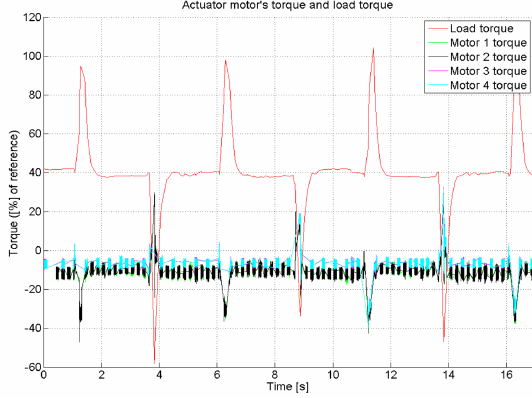
Figure 19. Response torques using master / slave